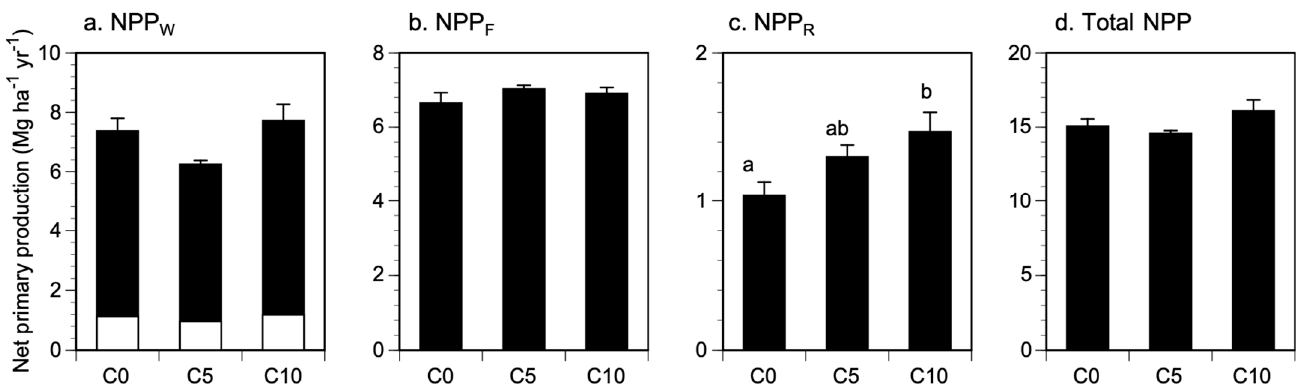
Figure 2. Effect of the application of biochar on net primary production and components in an oak ( Q. serrata ) forest. NPP W ( a ) included woody growth of aboveground (black part) and coarse root (white part). Total NPP ( d ) was the sum of NPP W ( a ), NPP F ( b ), and NPP R ( c ). Lower cases represent significant differences among biochar treatments based on one-way ANOVA followed by Tukey’s test.